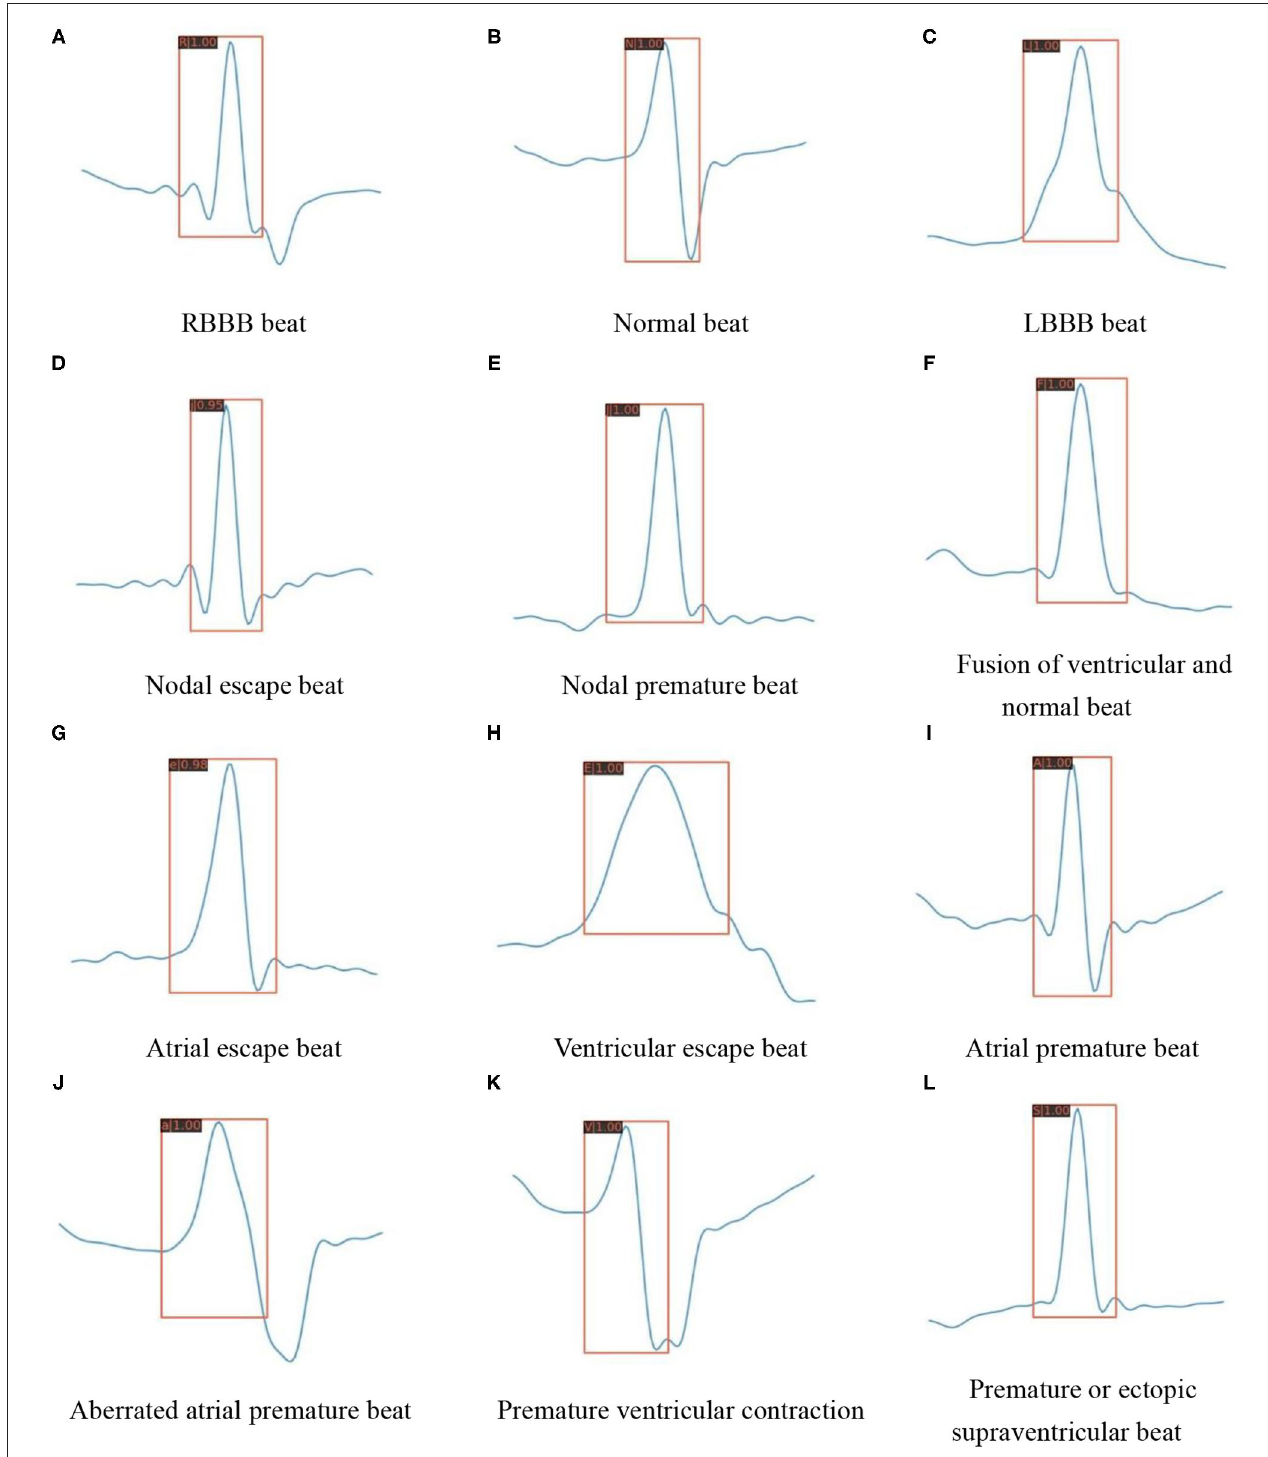
FIGURE 9 | Detection results of the proposed model on various heartbeat images. (A) RBBB beat. (B) Normal beat. (C) LBBB beat. (D) Nodal escape beat. (E) Nodal premature beat. (F) Fusion of ventricular and normal beat. (G) Atrial escape beat. (H) Ventricular escape beat. (I) Atrial premature beat. (J) Aberrated atrial premature beat. (K) Premature ventricular contraction. (L) Premature or ectopic supraventricular beat.